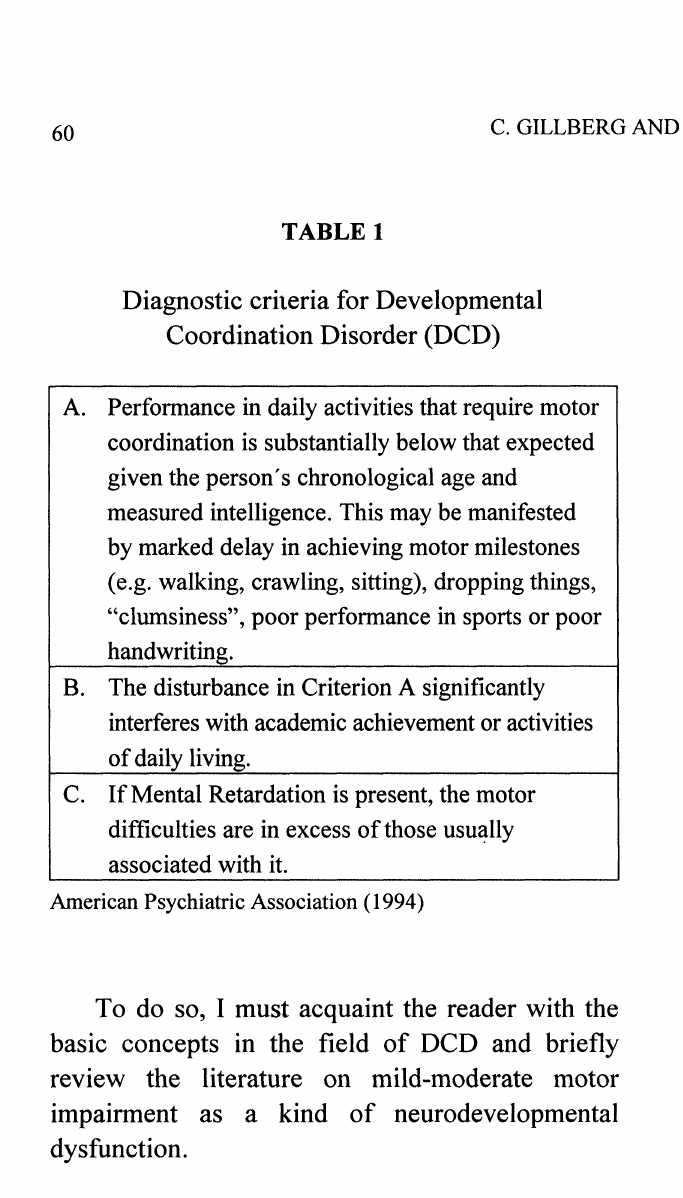
Diagnostic criteria for Developmental Coordination Disorder